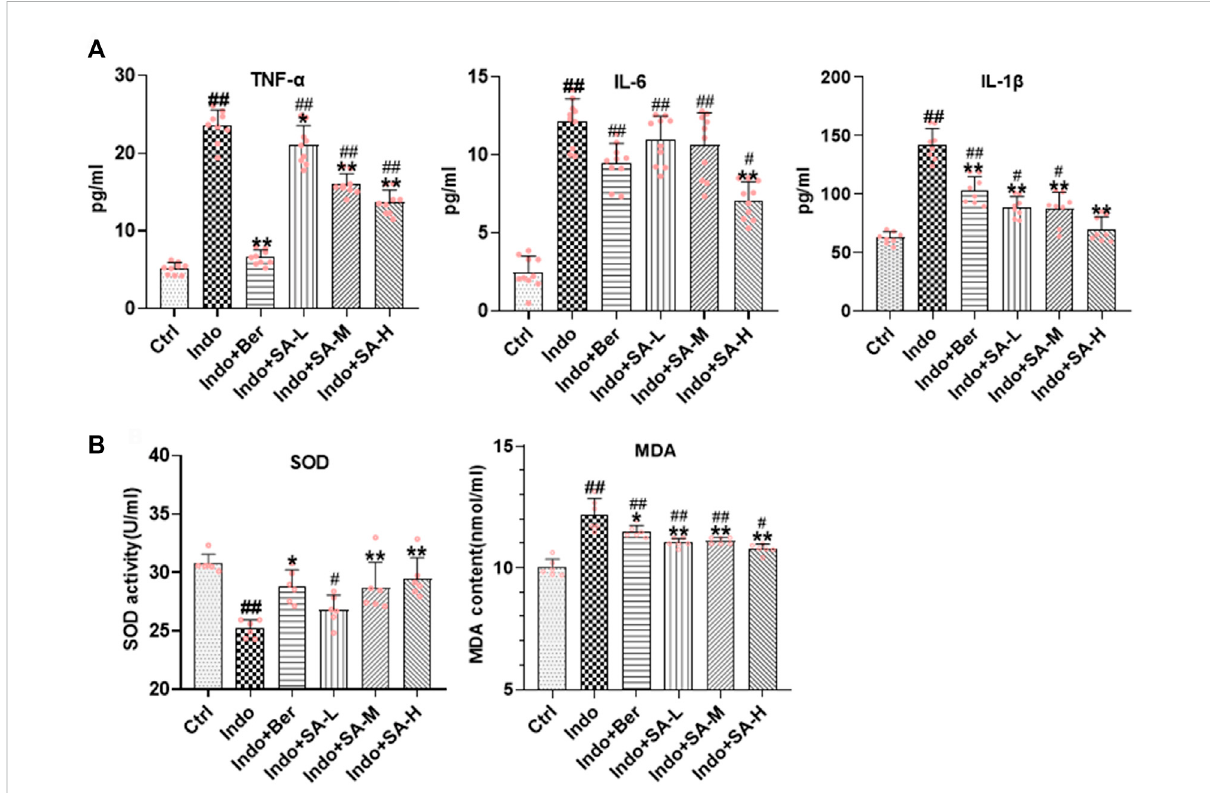
FIGURE 6 SA antagonized indomethacin-induced in fl ammatory and oxidative stress of IEC-6 cells. IEC-6 cells were treated with indomethacin (Indo, 300 μ mol L − 1 ) and/or sanguinarine (SA, 0.25, 0.5, and 1.0 μ mol L − 1 , SA-L, SA-M and SA-H, respectively) or with berberine (Ber, 30 mmol L − 1 ). (A) In fl ammatory cytokines. TNF- α ( left ), IL-6 ( middle ), and IL-1 β ( right ) were measured by ELISA ( n = 8). (B) Oxidative stress. MDA and SOD were detected using a colorimetric assay kit and a chemiluminescent assay kit, respectively ( n = 6). Data are presented as the mean ± SD. # p